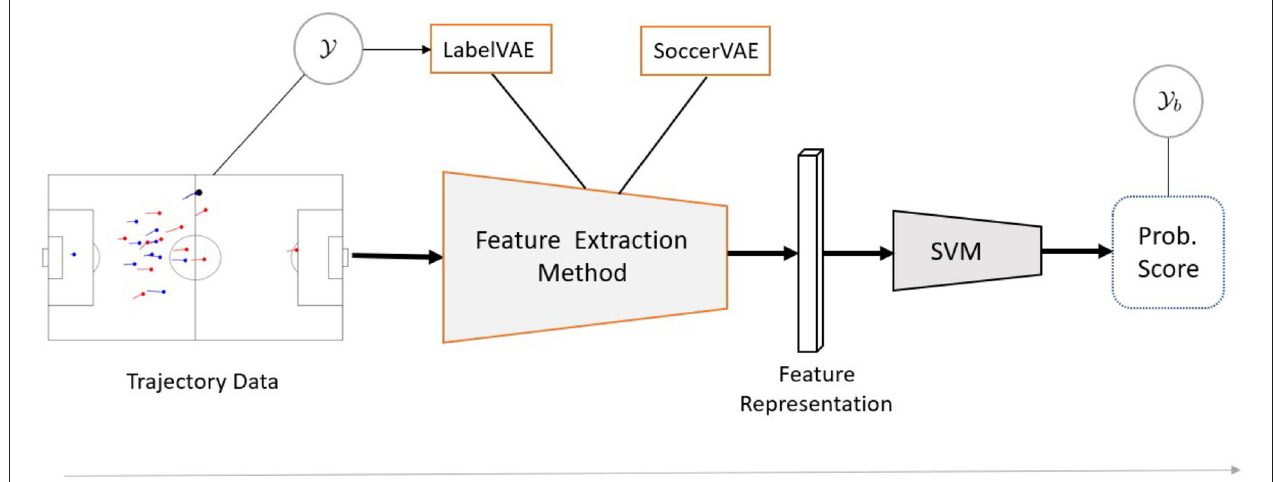
FIGURE 1 | Detection worflow. The building blocks outlined in orange are presented in sections Static Models, Sequential Models and denote the technical contributions of this paper. The proposed LabelVAE methods for feature extraction operate on Y , while the SoccerVAE methods are trained fully